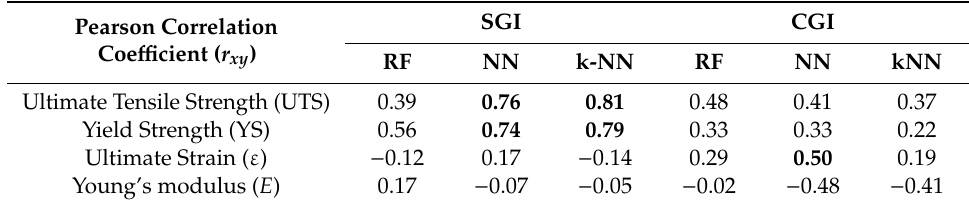
Table 8. Correlation between measures and predictions in terms of Pearson correlation coefficient. Pearson Correlation Coefficient ( r xy )